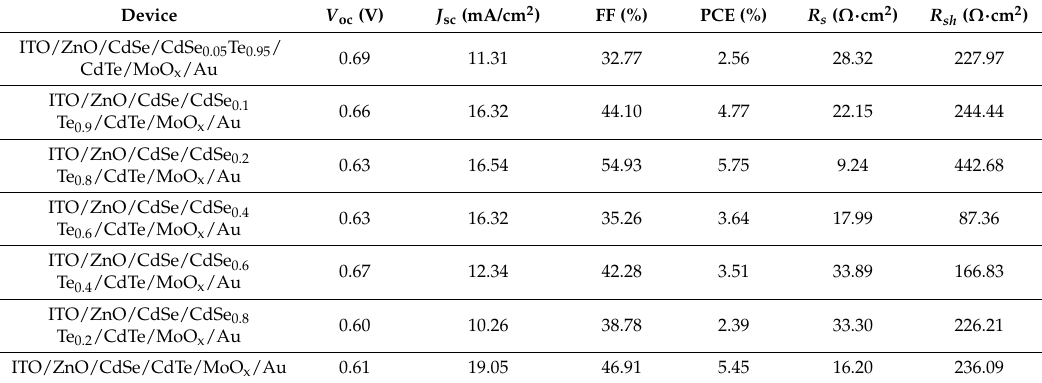
Table 3. Summarized performances of vertically-graded bandgap NC solar cells (Figure 5).